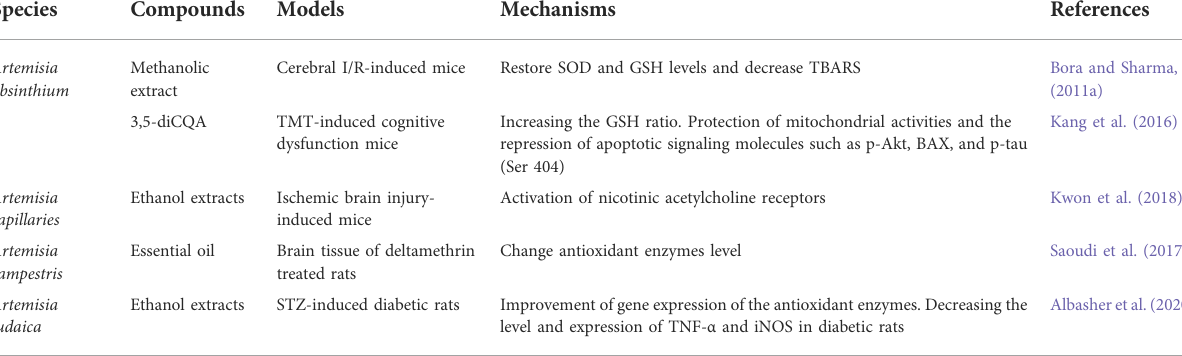
TABLE 2 Antioxidant, anti-in fl ammatory, and neuroprotective effects of Artemisia species in vivo and its mechanisms of action.